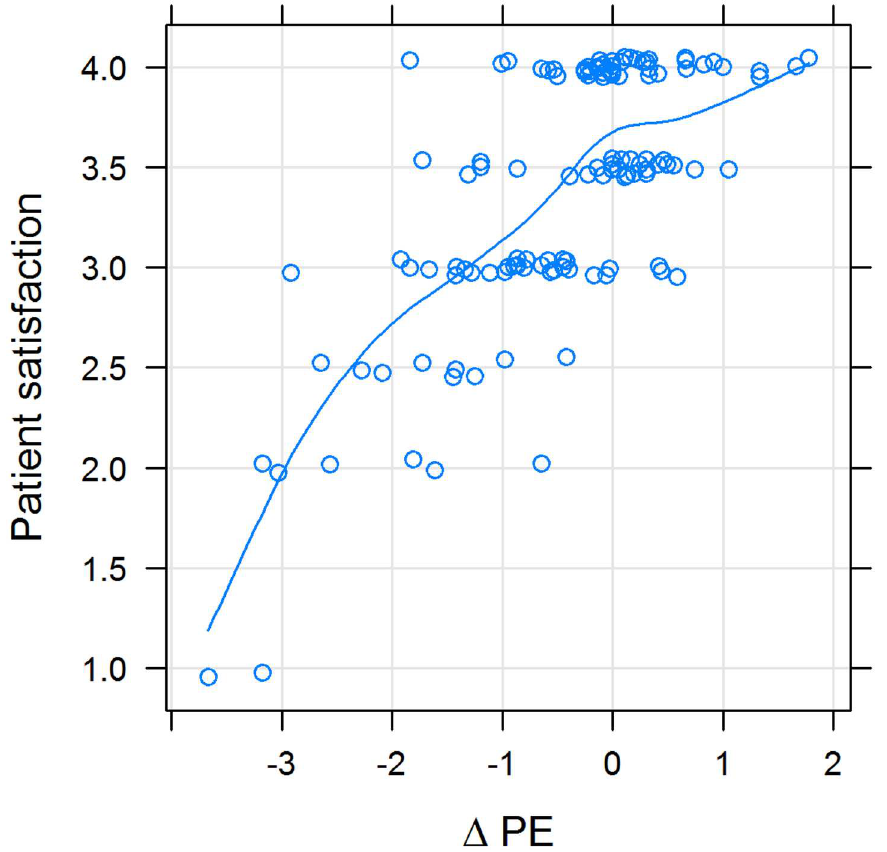
Fig 5. Patient satisfaction with the physician as a function of the difference between desired and perceivedphysician empathy ( Δ PE); X-Y scatterplot. Variableswere positivelycorrelated (rho = 0.47; p < 10 − 10 ). The line represents a cubic smoothingsplinefit. If Δ PE was negative, patient satisfaction was low and rose steeply; and if it was positive, patient satisfaction rose less